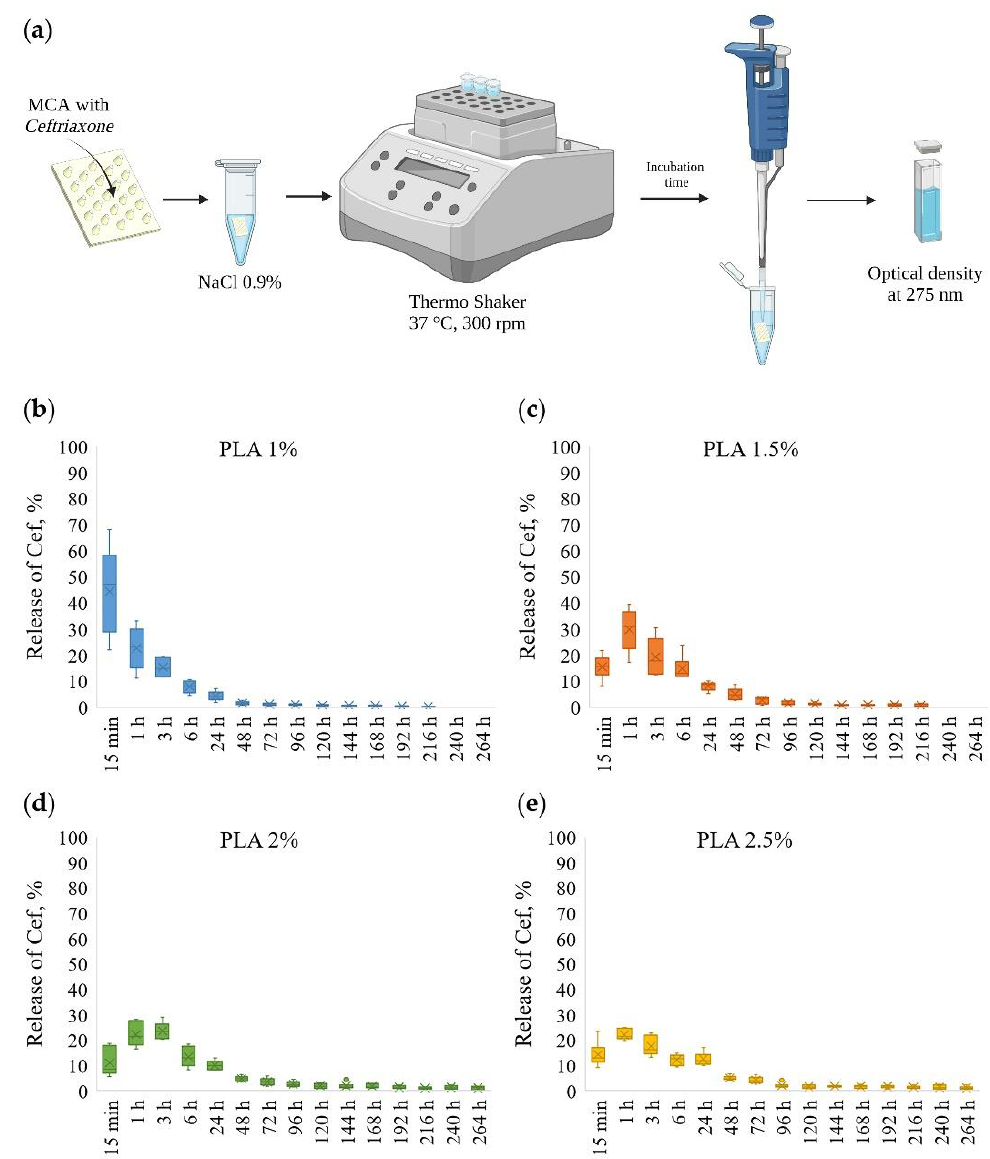
Figure 4. The scheme for the determination of prolonged release of ceftriaxone from microchamber arrays ( a ); prolonged release profiles of ceftriaxone from microchamber arrays prepared at various concentrations of PLA in a patterned film (from 1 to 2.5%) ( b – e ).